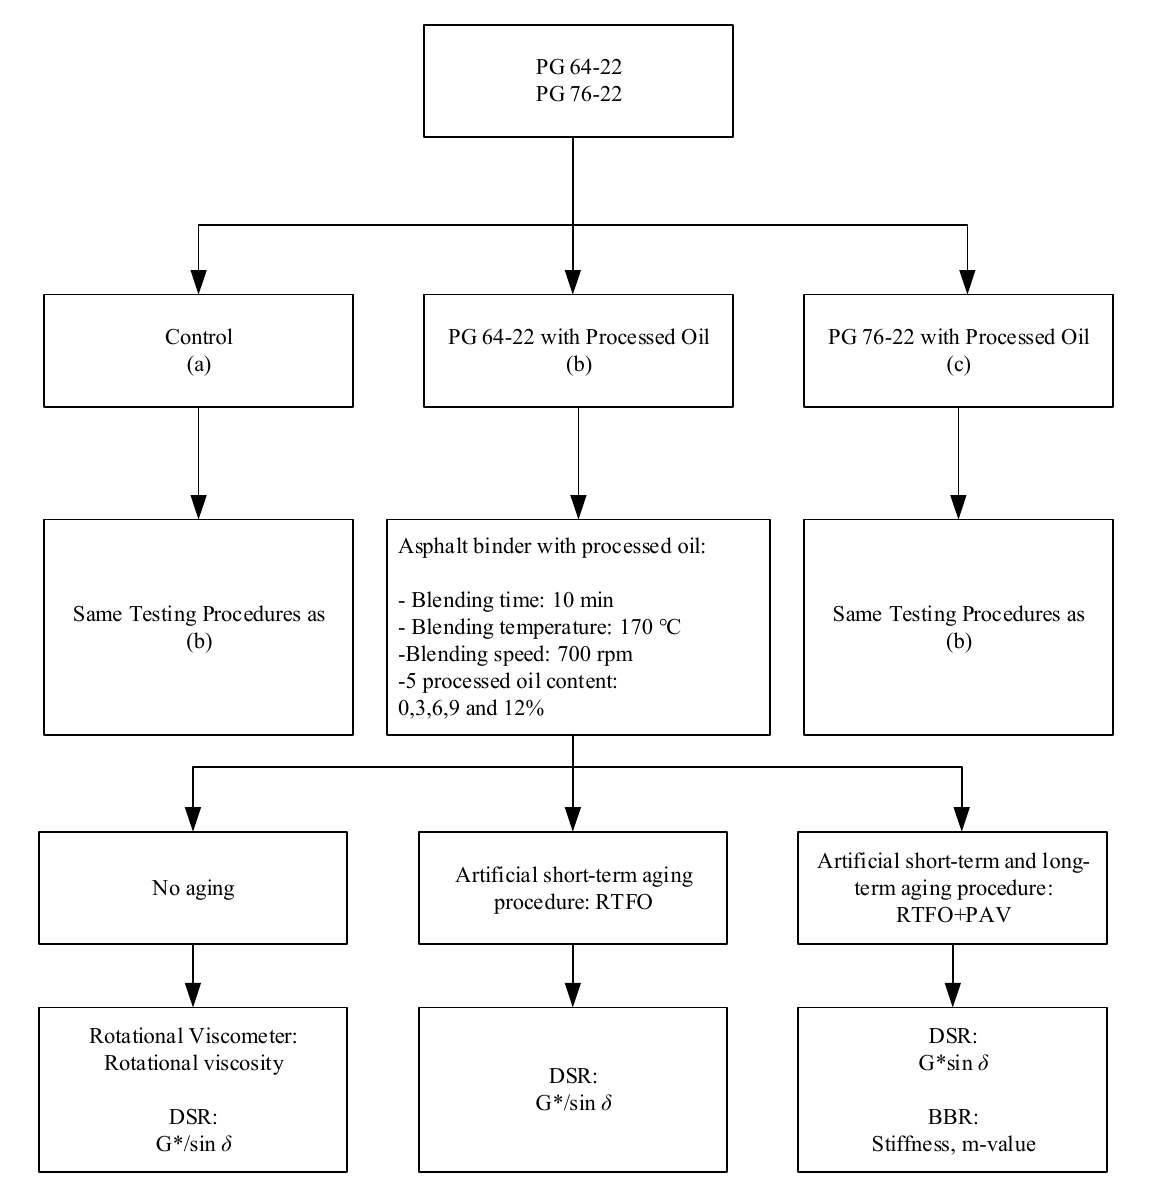
Figure 1. Flow chart of experimental design procedures.